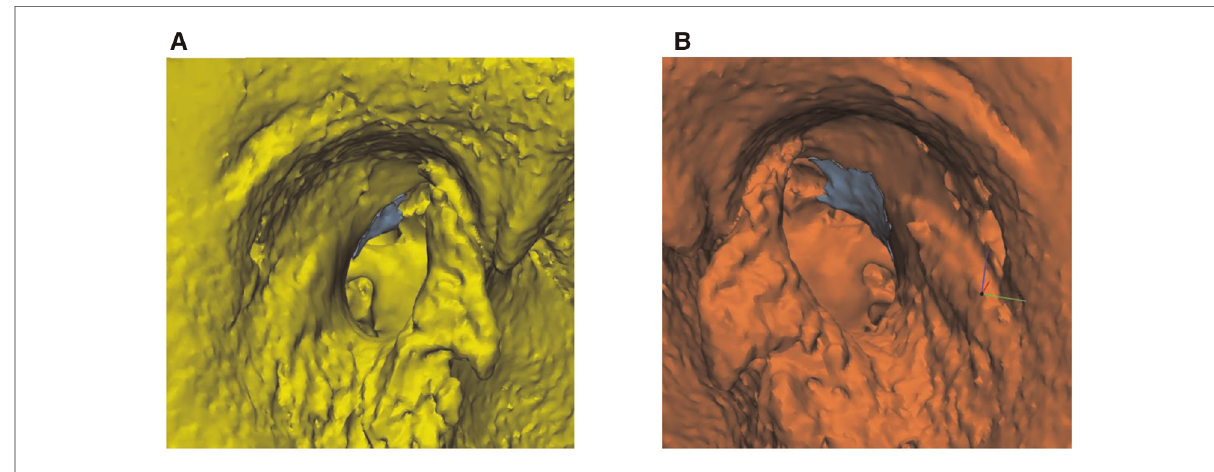
FIGURE 5 Volumetric three-dimensional (3D) evaluation of scutum removal in an endoscopic and microscopic ear. ( A ) The blue area represents the resected scutum volume in an endoscopic ear. ( B ) The blue area represents the resected scutum volume in a microscopic